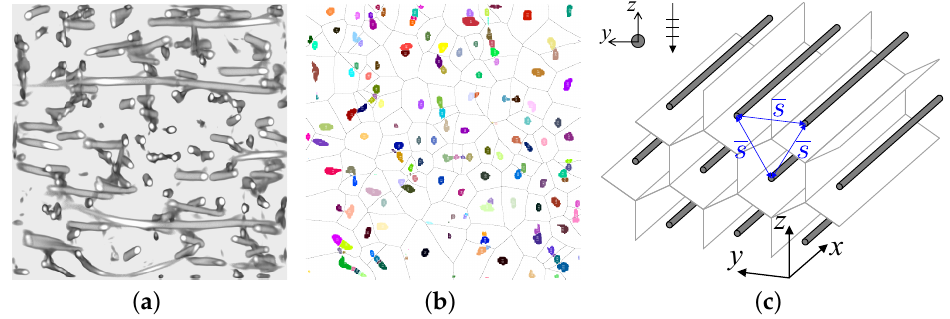
Figure 2. ( a ) Front view of the 3D micro CT slice image at the position shown in the isometric view of the 3D model. ( b ) Voronoi diagram of the 2D slice image. ( c ) Array of parallel cylindrical fibres with ideal hexagonal Voronoi regions.